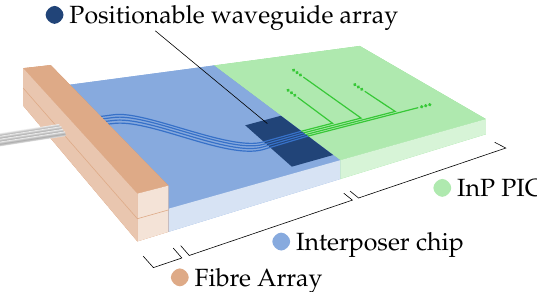
Figure 1. Alignment assembly with the fiber array, interposer chip and indium phosphide (InP) photonic integrated circuit (PIC). The location of the positionable waveguide array on the interposer chip is